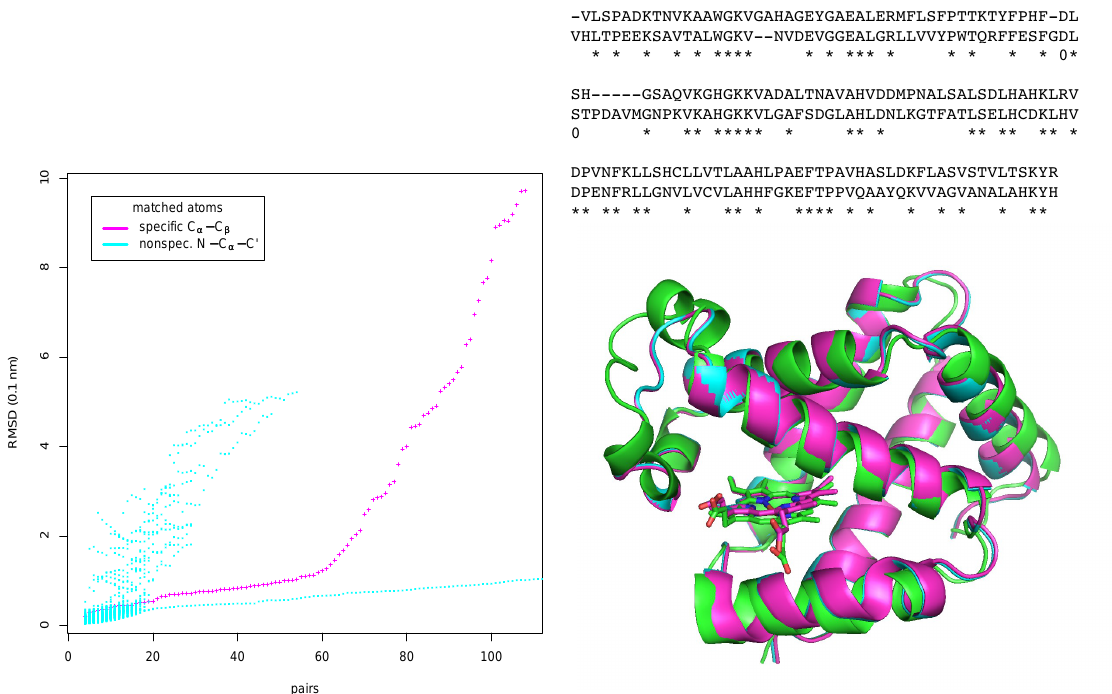
Figure 5. Matching α - and β -chains of human hemoglobin. Left: matched pairs of amino- acids vs. RMSD after optimal superposition for two matching modes. Right bottom: optimal superposition of the match of β -chain (green) with α -chain matched using the amino-acid specific mode (magenta), and the unspecific mode (cyan). Right top: sequence alignment ( α -chain in top row, β -chain in bottom row) derived from the structural alignment. Matching pairs of amino-acids are marked with